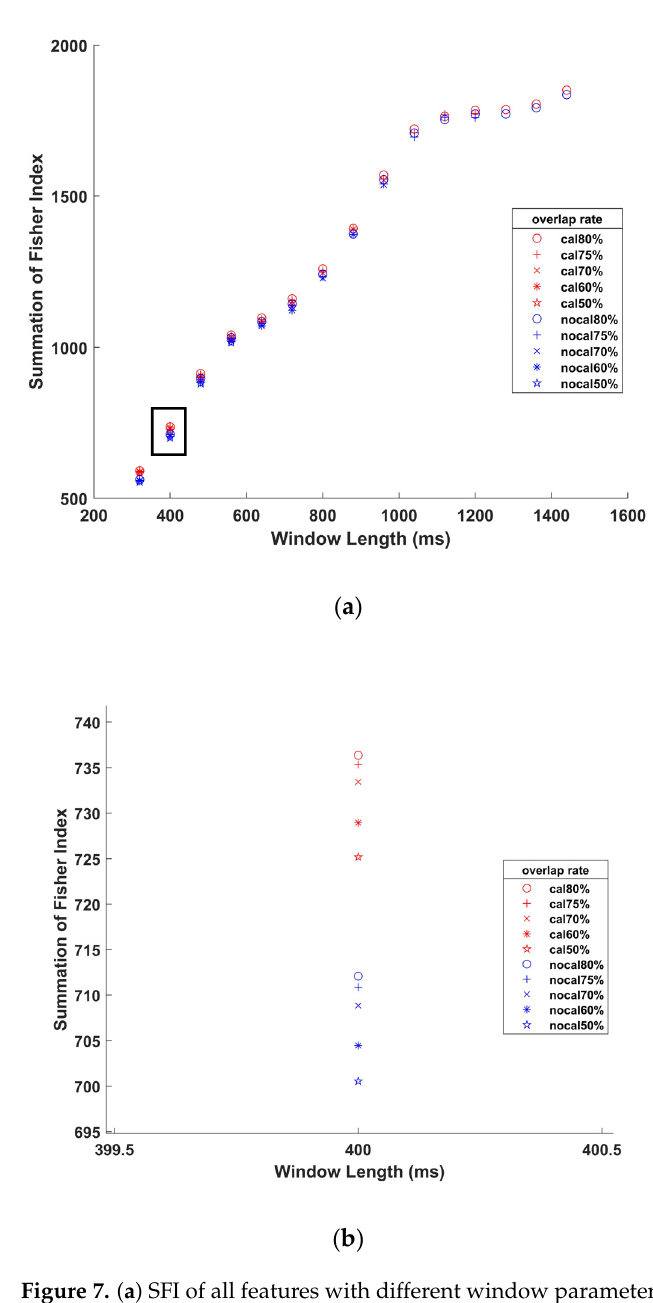
Figure 7. ( a ) SFI of all features with different window parameter pairs with and without calibration of IMUs. ( b ) Enlarge details of the black box in ( a ) at the window length of 400 ms. Where red means calibrated and blue means uncalibrated.